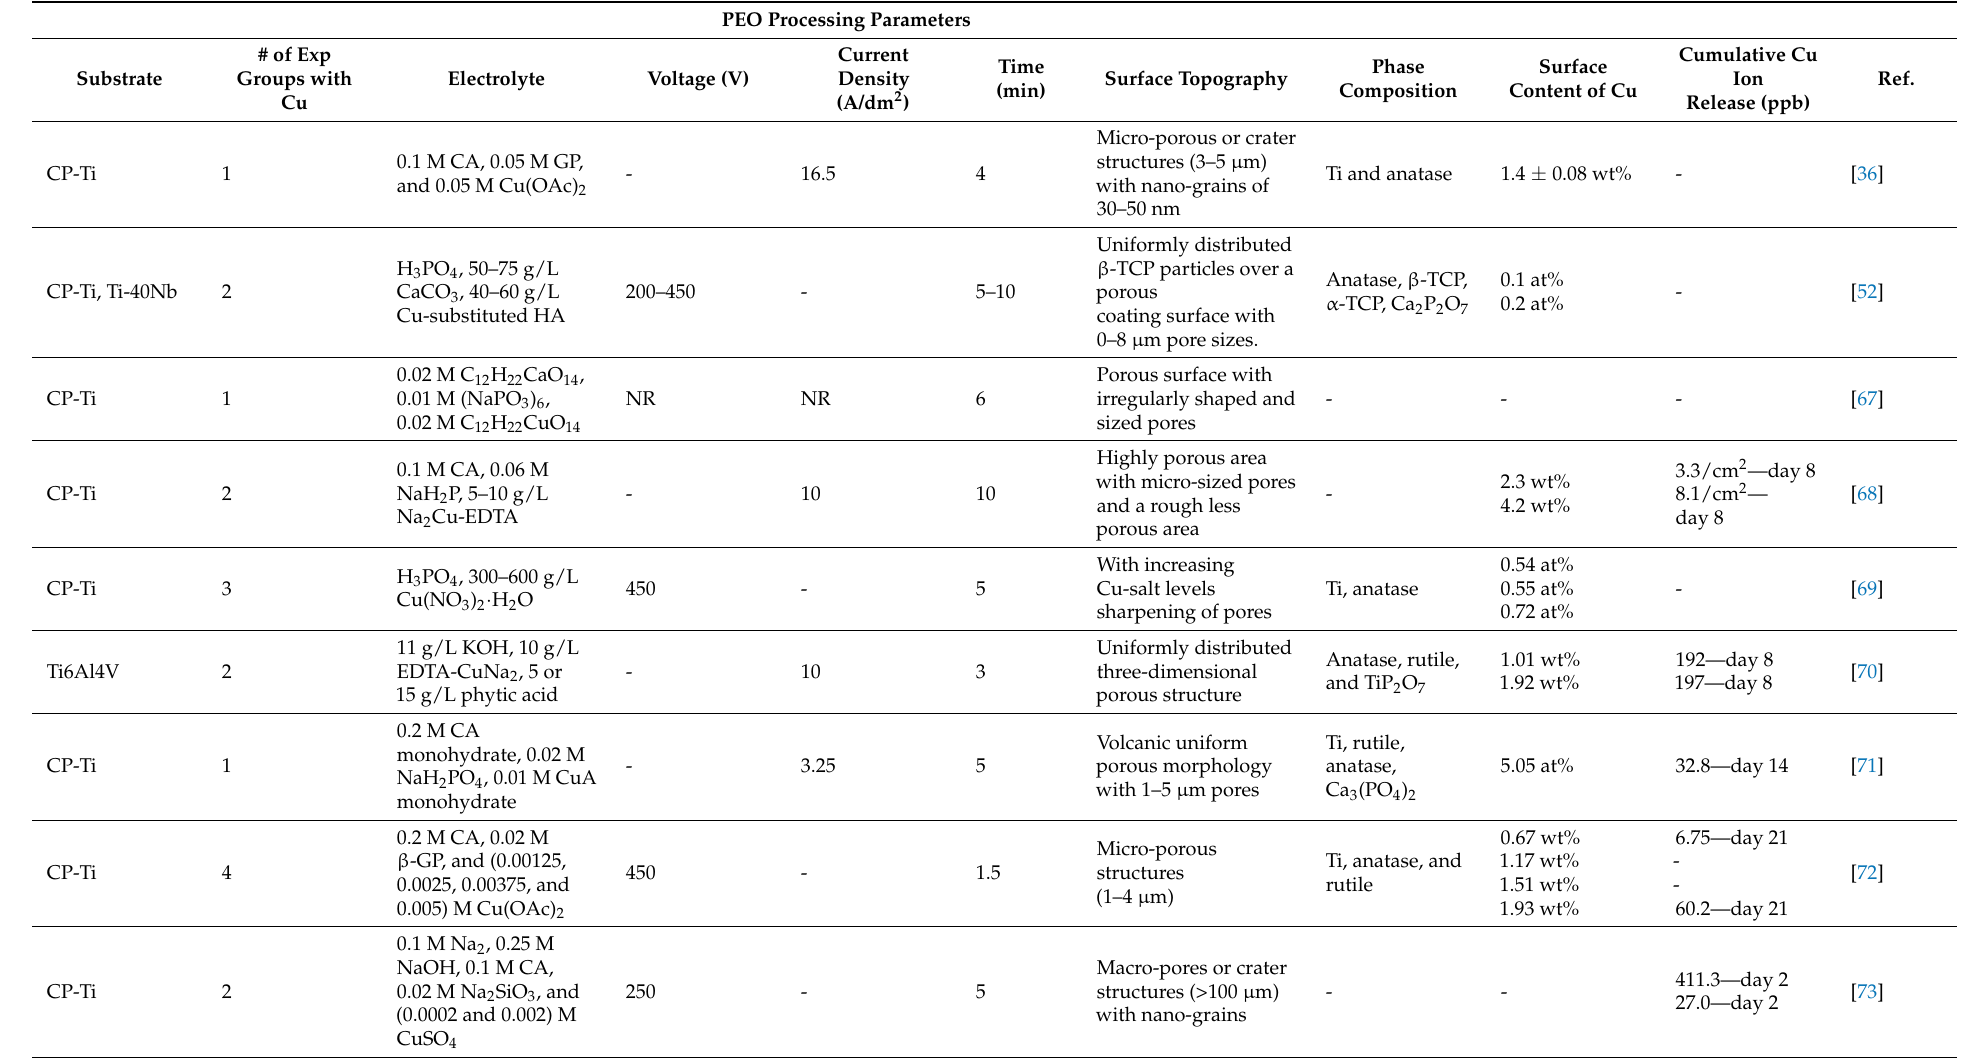
Table 2. The methodological details of the included studies in which Cu was used as the antibacterial agent. PEO Processing